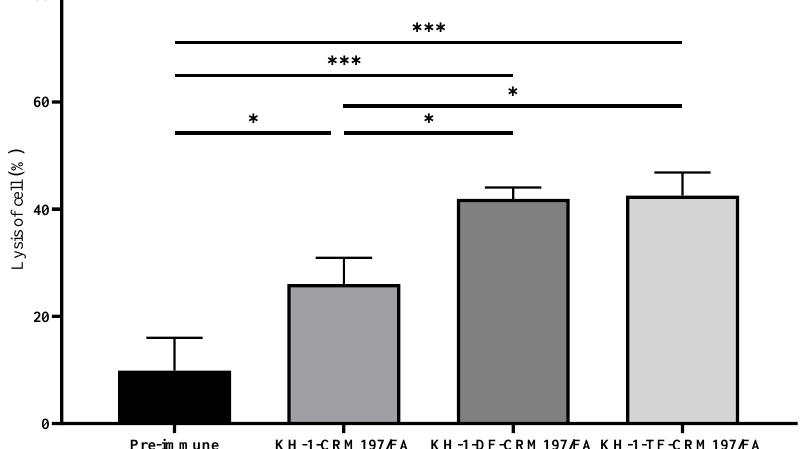
Figure 5. Antibodies elicited by glycoconjugates mediate complement-dependent cytotoxicity (CDC) to eliminate KH-1-positive MCF-7 cancer cells. Cell lysis of pooled sera (1:20 dilution) after the 4th vaccination. Data are the mean ± SEM of three independent experiments. Cytotoxicity is shown as percentage cell lysis determined by the lactate dehydrogenase (LDH) assay. Results are representative of three independent experiments. One-way ANOVA analysis was performed. * p < 0.05, *** p <